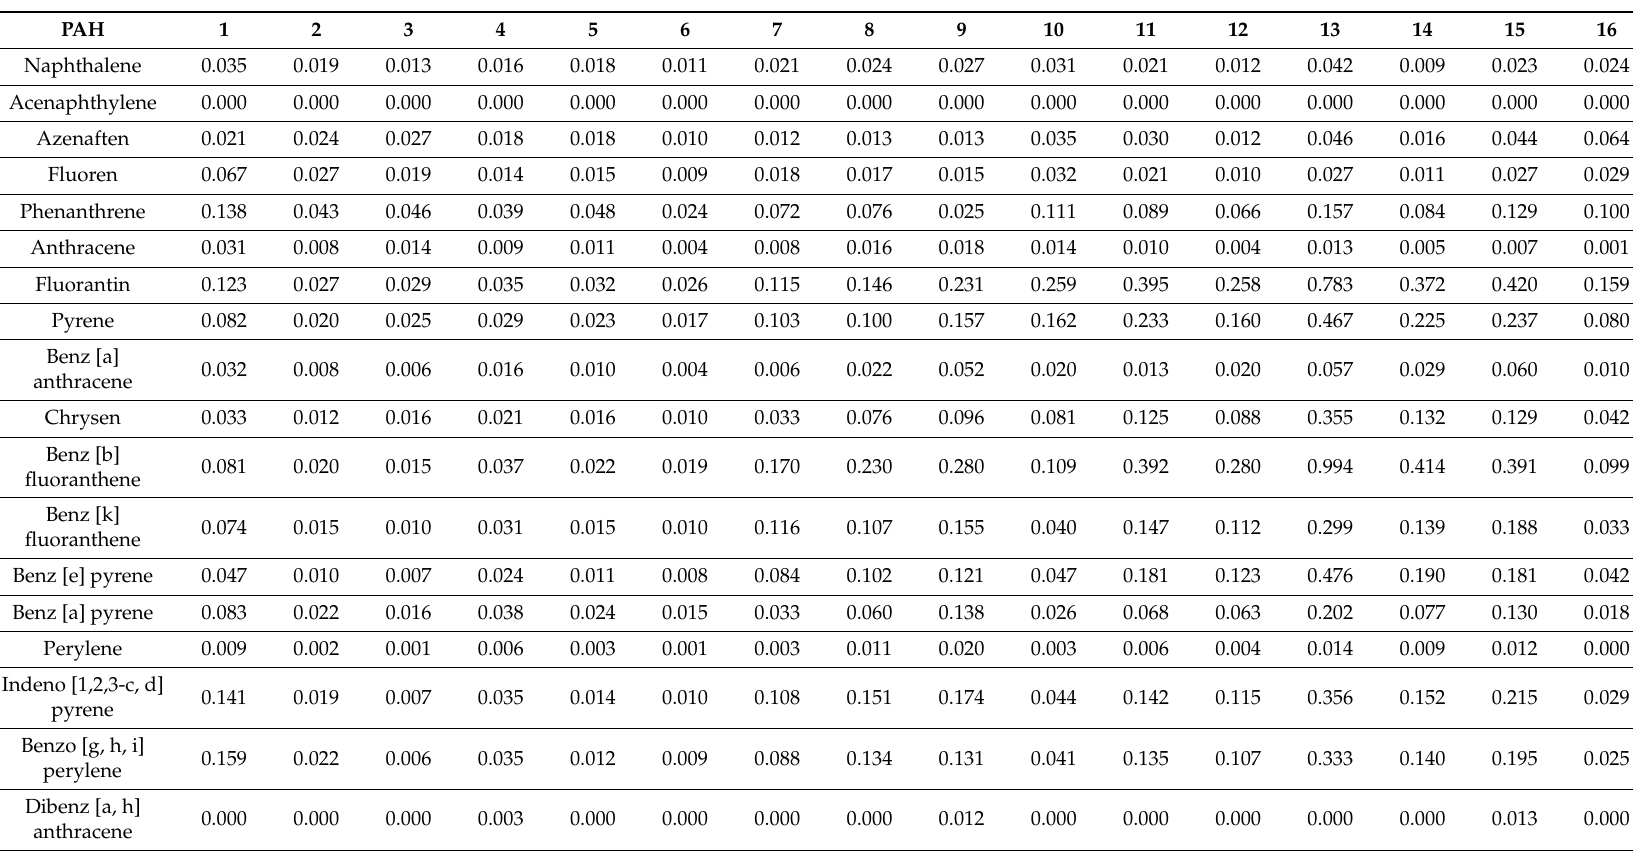
Table 6. Concentrations of individual PAHs in the composition of the aerosol in the near-water layer above Lake Baikal along the route of the RV «Akademik V.A. Koptyug» from 24 July to 4 August 2019, ng / m 3 (the RV route 1–16 see in the Table